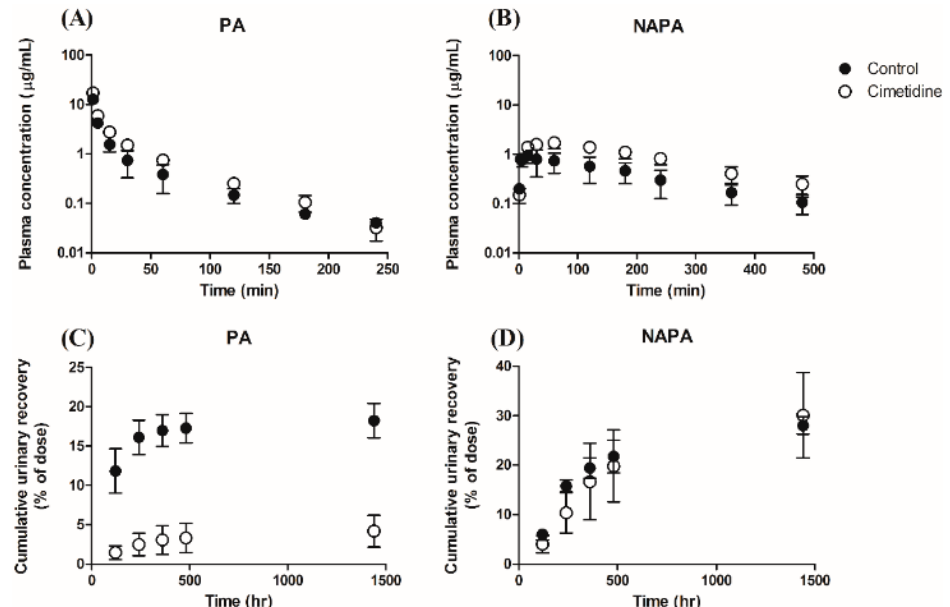
Figure 2. Temporal profiles of plasma concentrations of ( A ) PA and ( B ) NAPA, and the cumulative urinary excretions of ( C ) PA and ( D ) NAPA, after 10 mg/kg dose of PA HCl in rats, in the absence or presence of cimetidine (10 min before PA administration). Closed and open circles represent results observed without (control) or with cimetidine. Symbols represent the mean ± S.D ( n = 4, for each group).